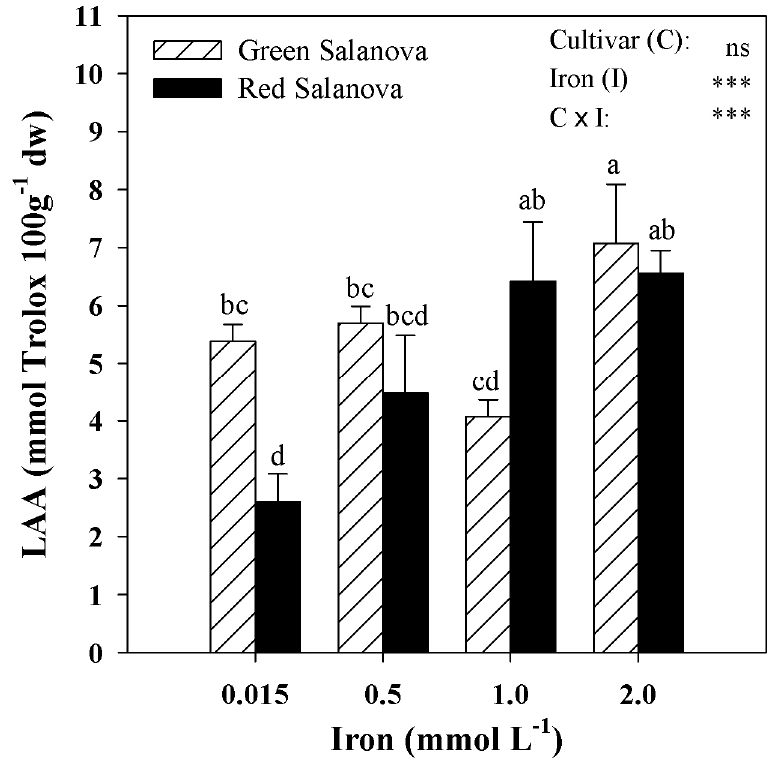
Figure 4. Effects of cultivar and iron concentration in the nutrient solution lipophilic antioxidant activity (LAA) in lettuce leaves. Different letters indicate significant differences according to Tukey’s HSD test ( P = 0.05). The values are means of three replicates. Vertical bars indicate ± standard deviation of means.